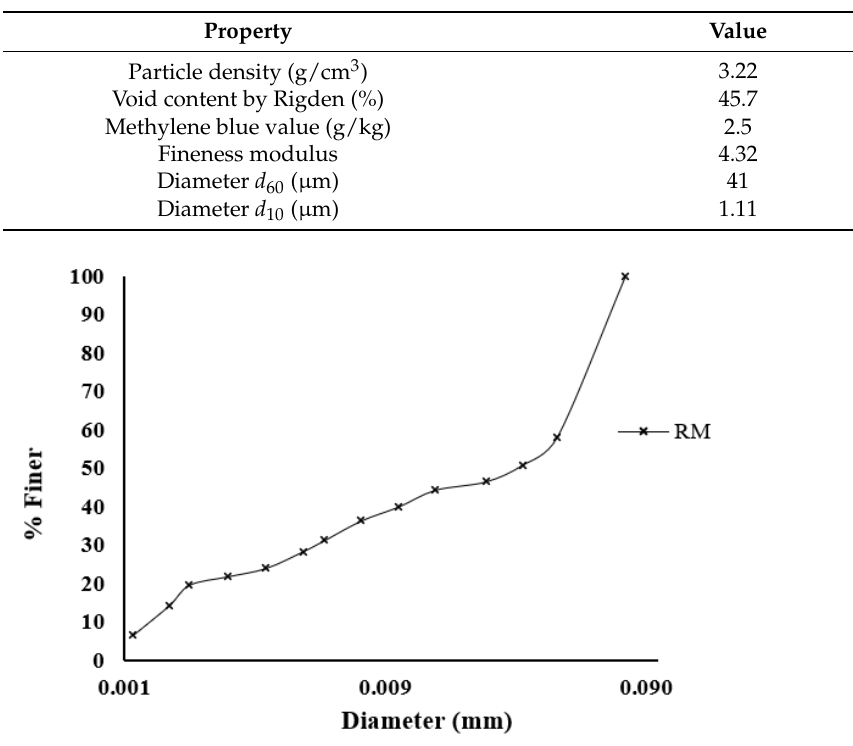
Table 1. Physical properties of filler.